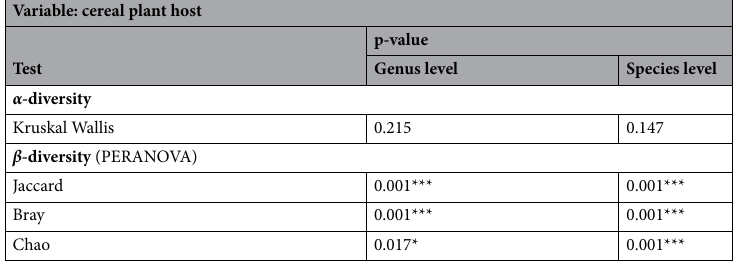
Table 4. The results of the statistical analysis presented as the p-values of the tests used to characterize the alpha and beta diversity of bacterial genera and species associated with CLB depending on the cereal plant host on which the insects were feeding. Significant codes for p-value: ***0.001, 0.01, *0.05, 0.1,